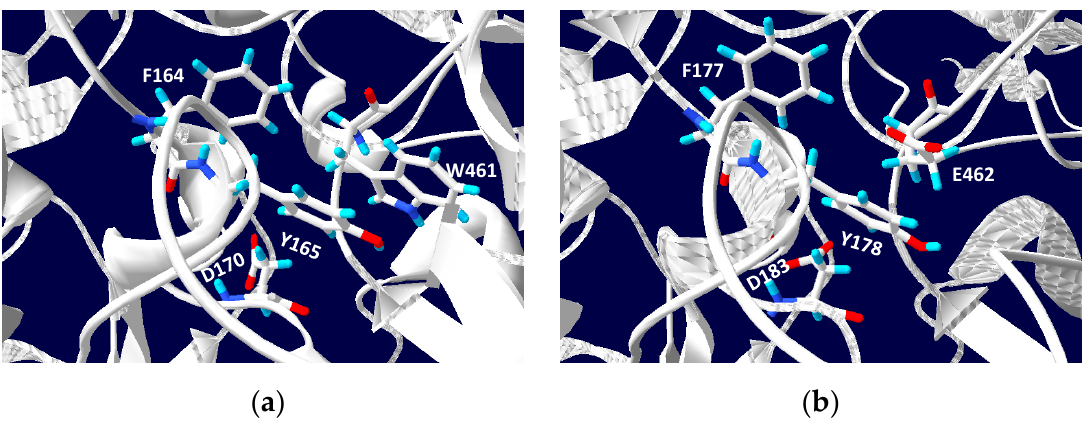
Figure 9. ( a ) Structure of the closed tunnel in PcrA from A. oryzae (PDB ID:4YDD). The gate residues F164, Y165, and W461 are shown in stick. ( b ) Model of NarG from H. mediterranei . The same positions of the hydrophobic tunnel in PcrA are showing in NarG structural model. W461 is substituted by E462 in the halophilic NarG. Blue: Nitrogen; Cyan; hydrogen; Red: oxygen.